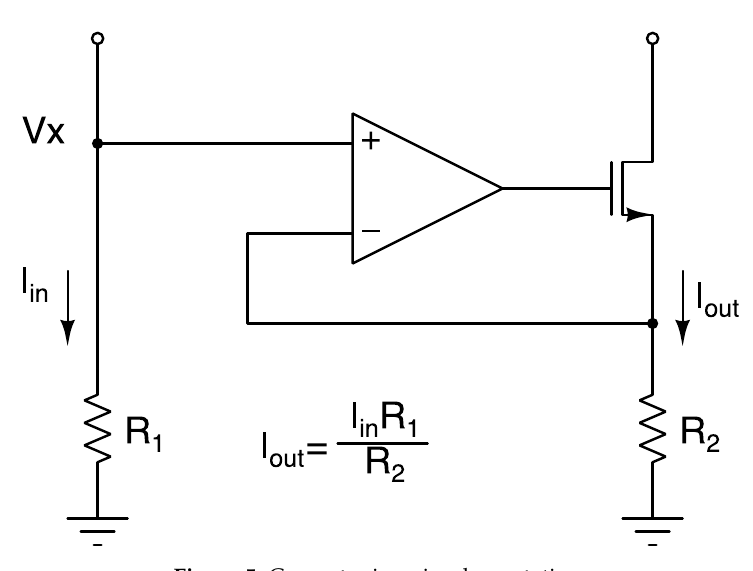
Figure 5. Current mirror implementation.